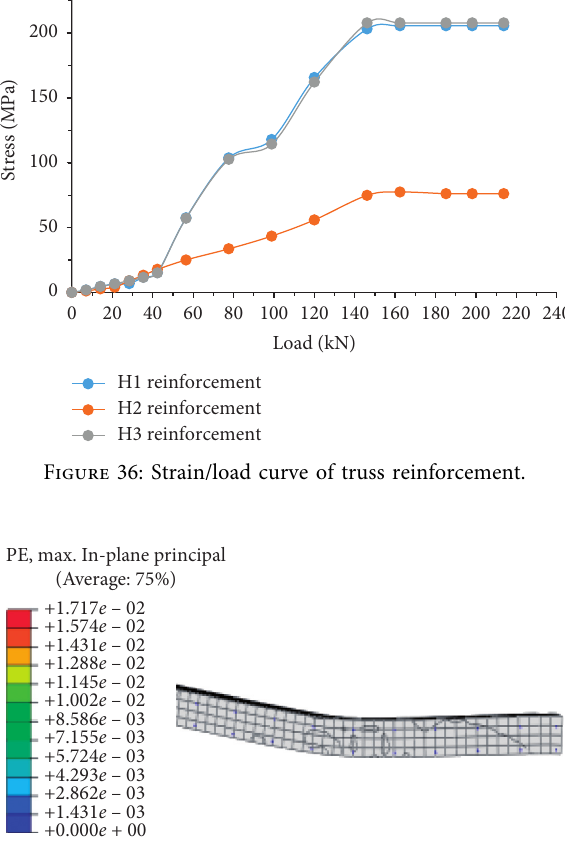
Figure 37: Cloud chart of the fractures on the composite slab along the long-span direction.